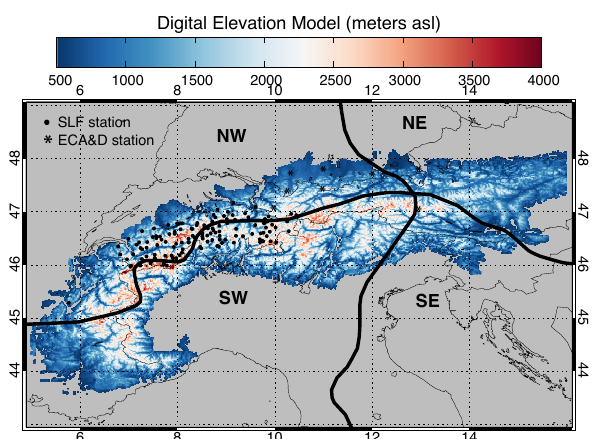
Fig. 1. Digital elevation model of the Alpine region. Black dots represent station locations used for the validation of the product. Bold lines indicate the subdivision into the four subregions (north-west, north-east, south-east and south-west) according to Auer et al. (2007). Data for the extra-alpine areas is not displayed.